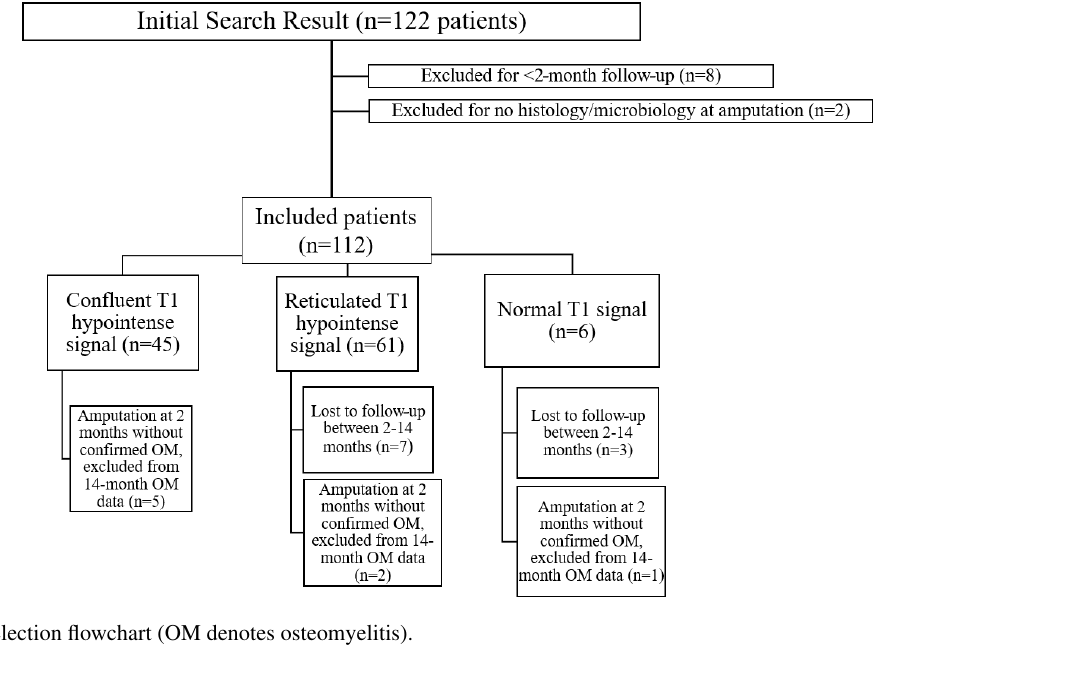
Figure 1. Patient selection flowchart (OM denotes osteomyelitis).